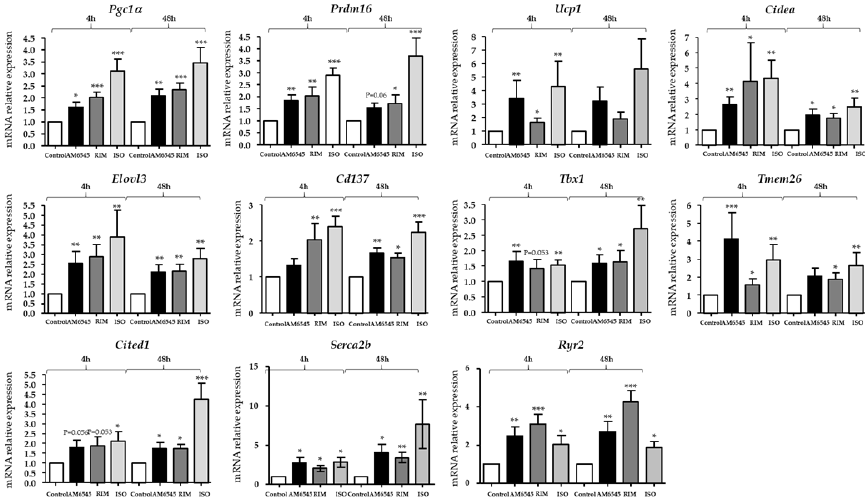
Figure 2. Peripheral cannabinoid receptor 1 (CB1R) antagonist increases markers of beiging in 3T3-L1 adipocytes. 3T3-L1-differentiated cells were treated with AM6545, rimonabant (RIM), and isoproterenol (ISO) for 4 and 48 h. Gene expression of beiging markers ( peroxisome proliferator-activated receptor gamma coactivator 1-alpha ( Pgc1a ), PR domain containing 16 ( Prdm16), uncoupling protein 1 ( Ucp1 ), cell death-inducing DFFA-like effector A ( Cidea ), elongation of very long chain fatty acids protein 3 ( Elovl3 ), tumor necrosis factor receptor superfamily member 9 ( Cd137 ), T-box transcription factor ( Tbx1 ), transmembrane protein 26 ( Tmem26 ), cbp/p300-interating transactivator 1 ( Cited1), sarco/endoplasmic reticulum Ca 2+ -ATPase 2b ( Serca2b ), and ryanodine receptor 2 ( Ryr2 )) was evaluated by RT-PCR. Data on graphs are presented as mean ± SEM of 4 independent rounds of the cells; * p < 0.05 vs. control ** p < 0.01 vs. control *** p < 0.001 vs. control.